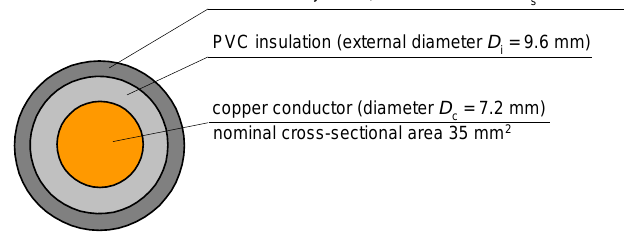
Figure 1. Construction of the considered low-voltage power cable.